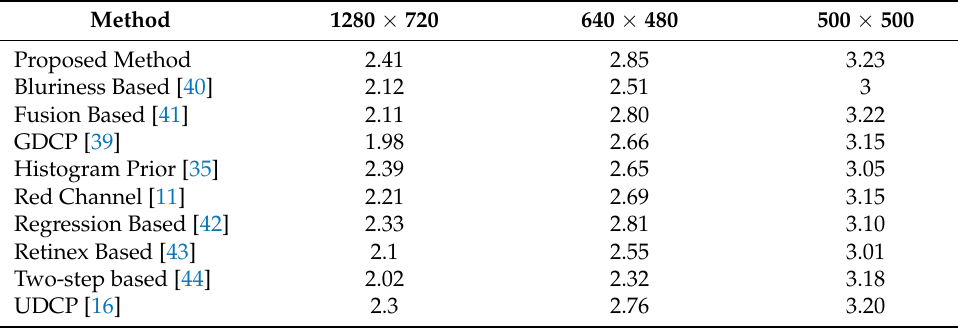
Table 7. Evaluation Metrics Comparison of UIQM